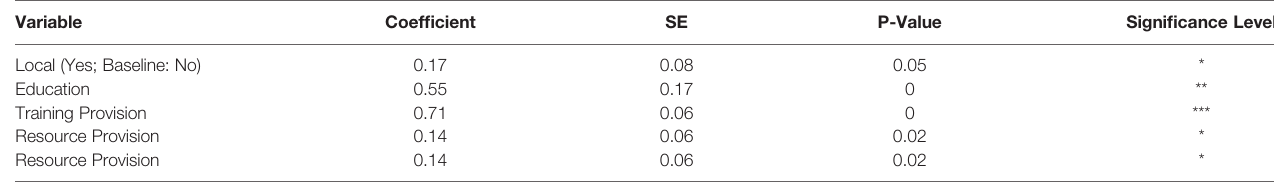
TABLE 5 | Coef fi cients, standard errors (SE) and p-values for the fi nal ordinal model with the dependent variable of perceived trust from local communities. Variable Local (Yes; Baseline: No)